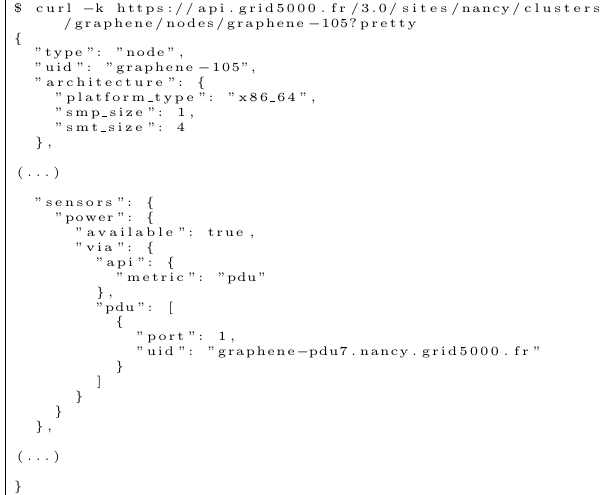
Figure 5: Node Description in Grid’5000 Reference